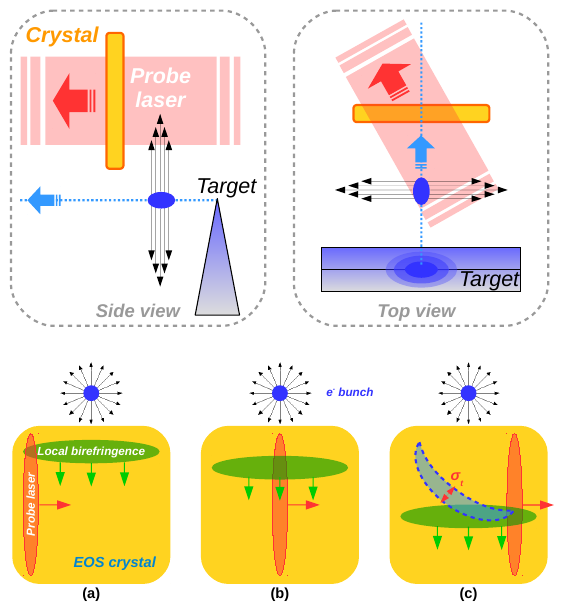
Figure 2. ( Top ) The emitted bunch travels normally to the crystal surface and moves below it while the probe laser crosses the crystal with a non-zero incidence angle; ( Bottom ) Spatial encoding process: ( a ) the bunch Coulomb field makes the crystal birefringent; ( b ) while the electric field penetrates into the crystal, the local birefringence shifts downwards; ( c ) the probe laser crosses the crystal and its polarization is rotated: the resulting signal comes from the blue region, i.e., where the local birefringence and the probe laser temporally overlapped [20].